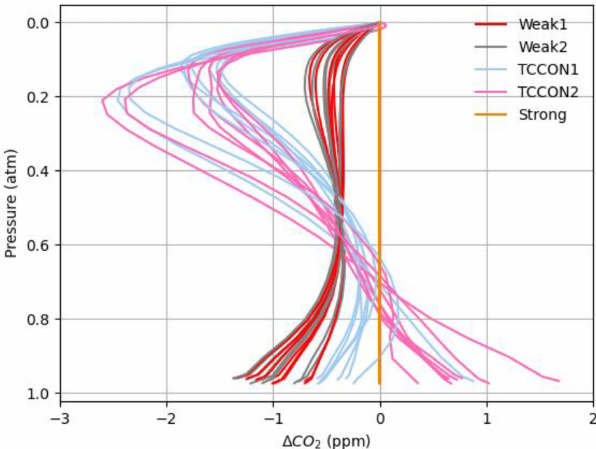
Figure F3. Using real Lamont spectra with the AirCore profile as the a priori profile, the zero-level offset was first retrieved from the Strong window and then added in the Weak and TCCON windows. The difference in the retrieved profiles with and without the added offset is shown for each window and for all the days with AirCore profiles over Lamont. In the Strong window, where the offset is re- trieved, the differences are less than